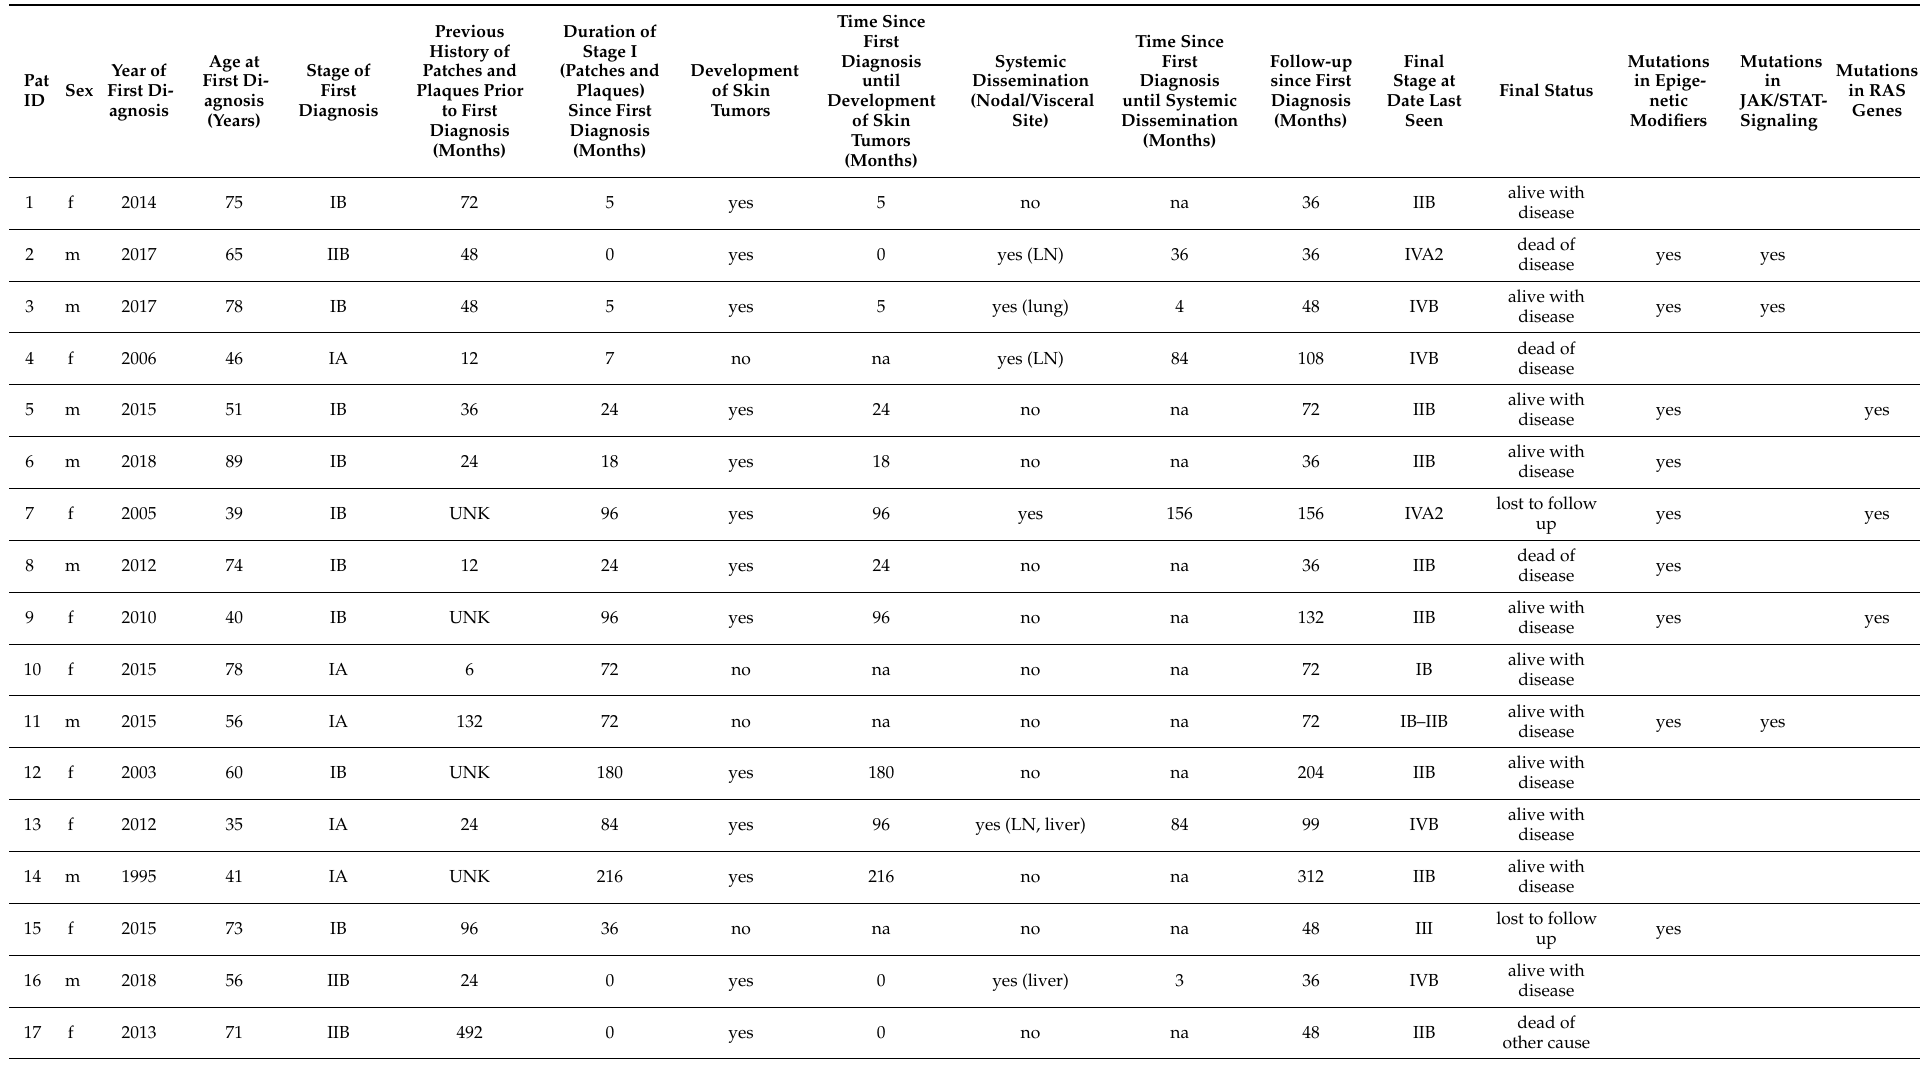
Table 1. Patient